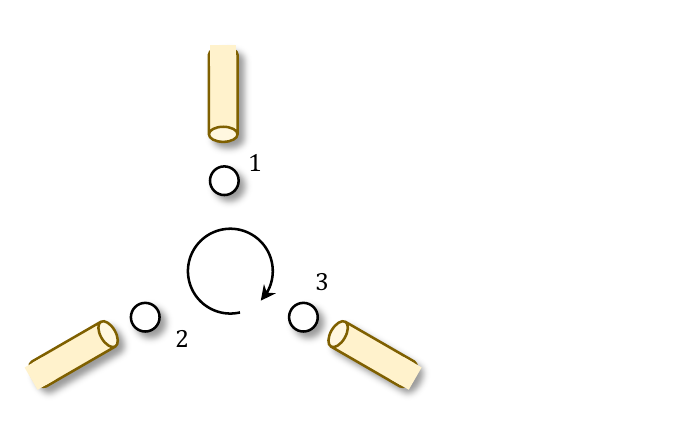
Figure 5: Schematic showing how our three-cavity ring (c.f. Eq. (35)) when coupled to input-output waveguides (coupling rate κ ) can function as a circulator of signals incident on the cavities at ω = 0. Achieving this circulator behaviour involves both tuning the synthetic gauge flux to Φ = π/ 2, and also requires careful tuning of the amount of dissipation induced by the waveguides, i.e. κ = 2 J